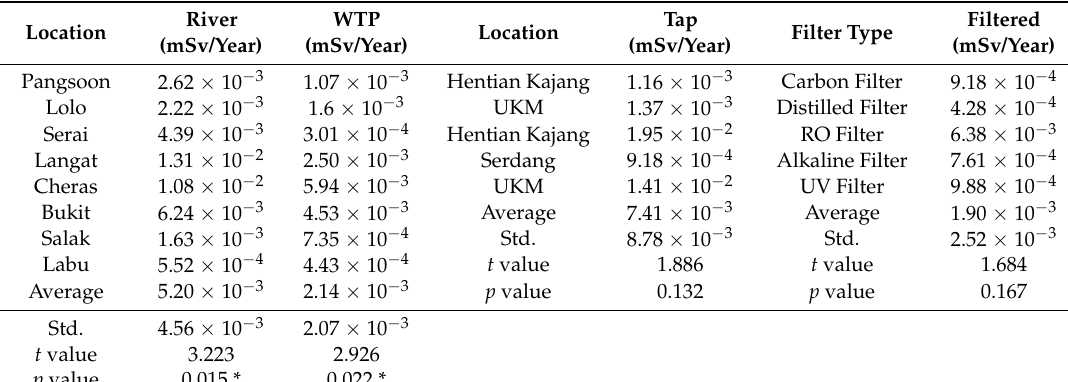
Table 10. Annual effective dose of Po-210 via drinking water at Langat River